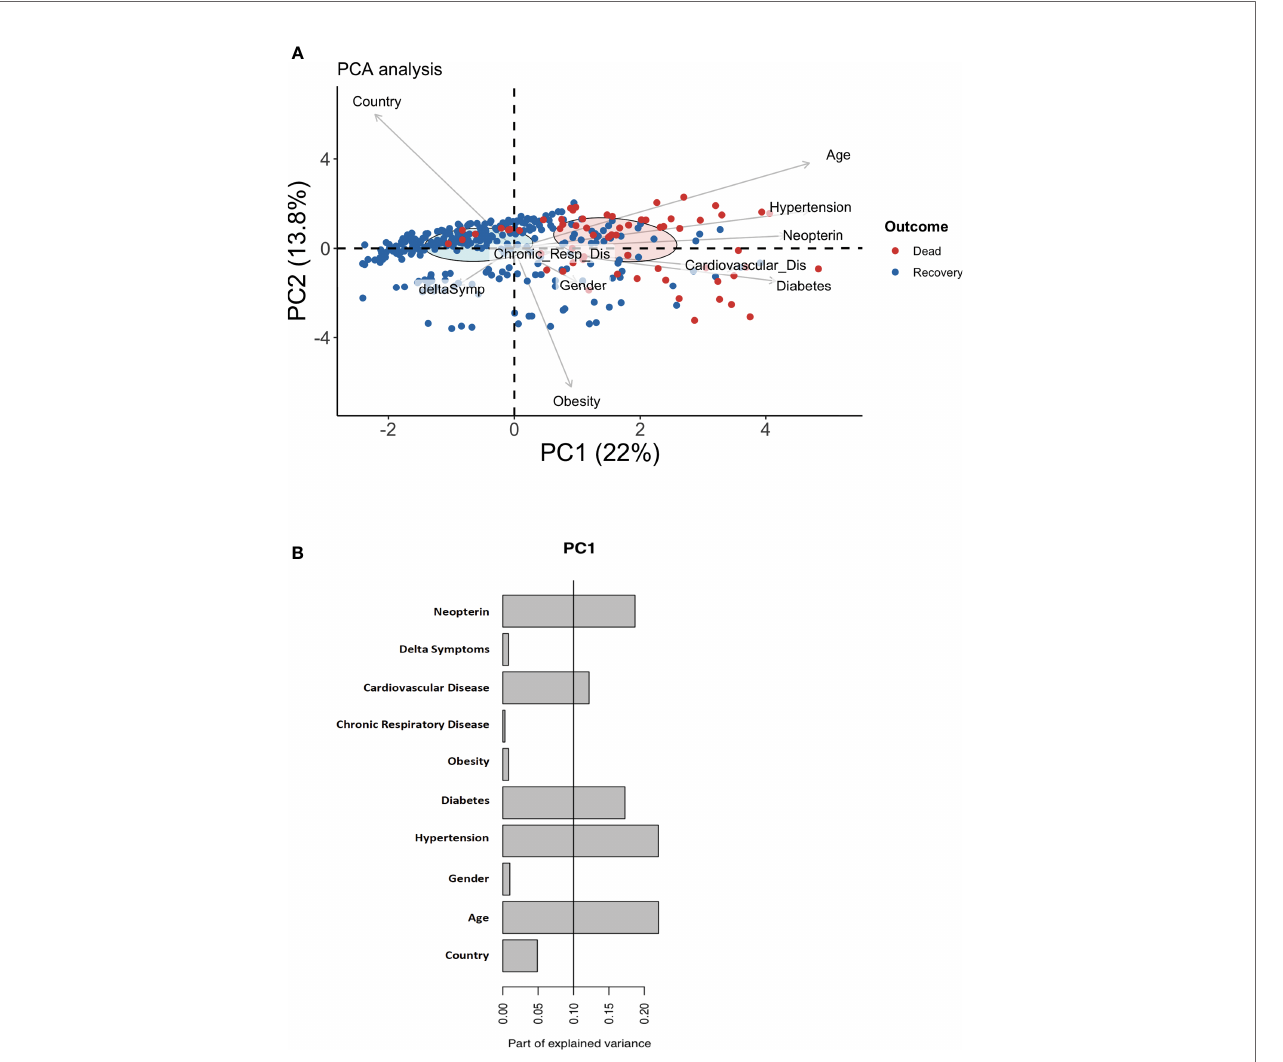
FIGURE 1 | Discriminating parameters to segregate Covid-19 suffering patents from healthy individuals. (A) Principal component analysis (PCA) using serum neopterin and clinical variables on hospitalized patients. Red symbols represent deceased patients. Blue symbols represent patients who recovered within one month-follow-up (survivors). (B) Histograms depicting the contribution of individual PCA parameters with regards to the variance of principal component 1